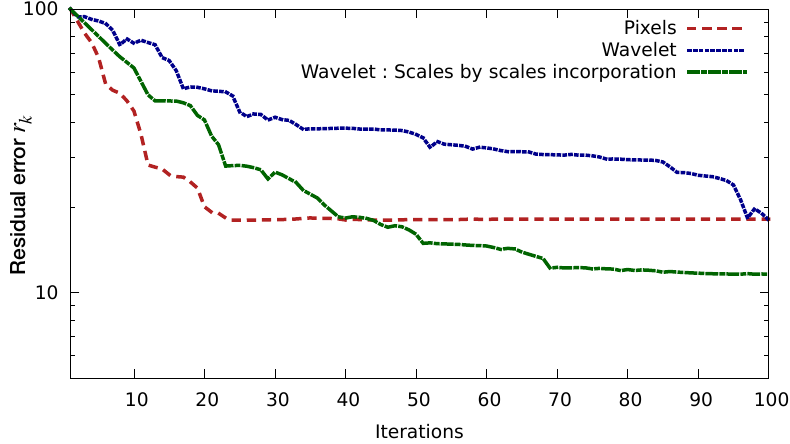
Figure 11. Ratio of the residual error as a function of minimisation iterations in the presence of inhomogeneously correlated observation errors, for three methods: pixels ( dashed red ), classical wavelet ( dotted blue ), modified wavelet ( dashdotted green